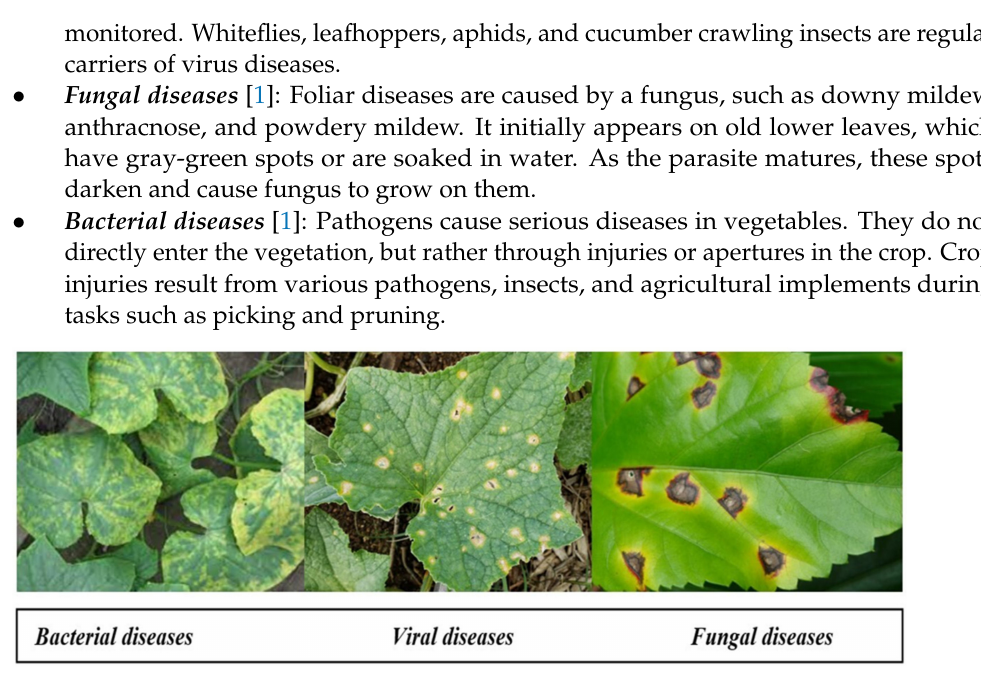
Figure 1. Different types of pathogens: viruses, fungi, and bacteria. Table 1. Classification of some leaf diseases with their